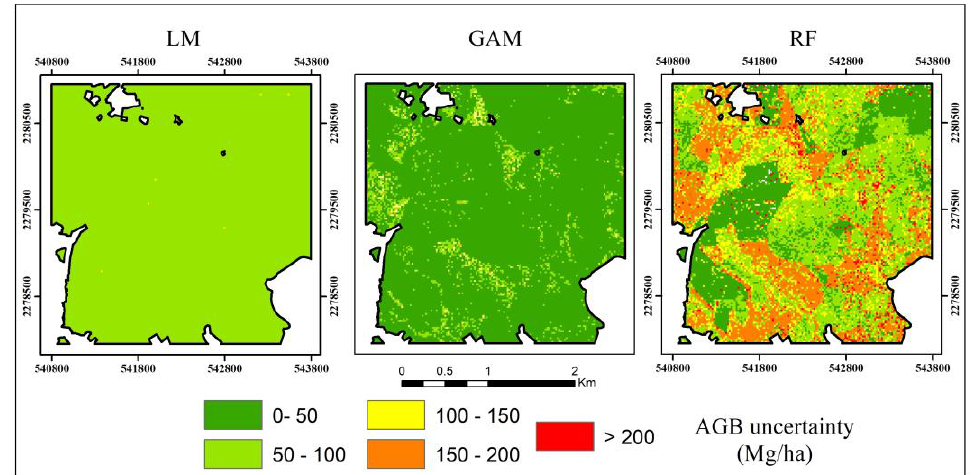
Figure 8. Distribution of AGB uncertainty (Mg ha −1 ) by LM (Linear Model), GAM (Generalized Additive Model), and RF (Random Forest) at the managed forest landscape in the Zacualtipán forested region (3 × 3 km area).